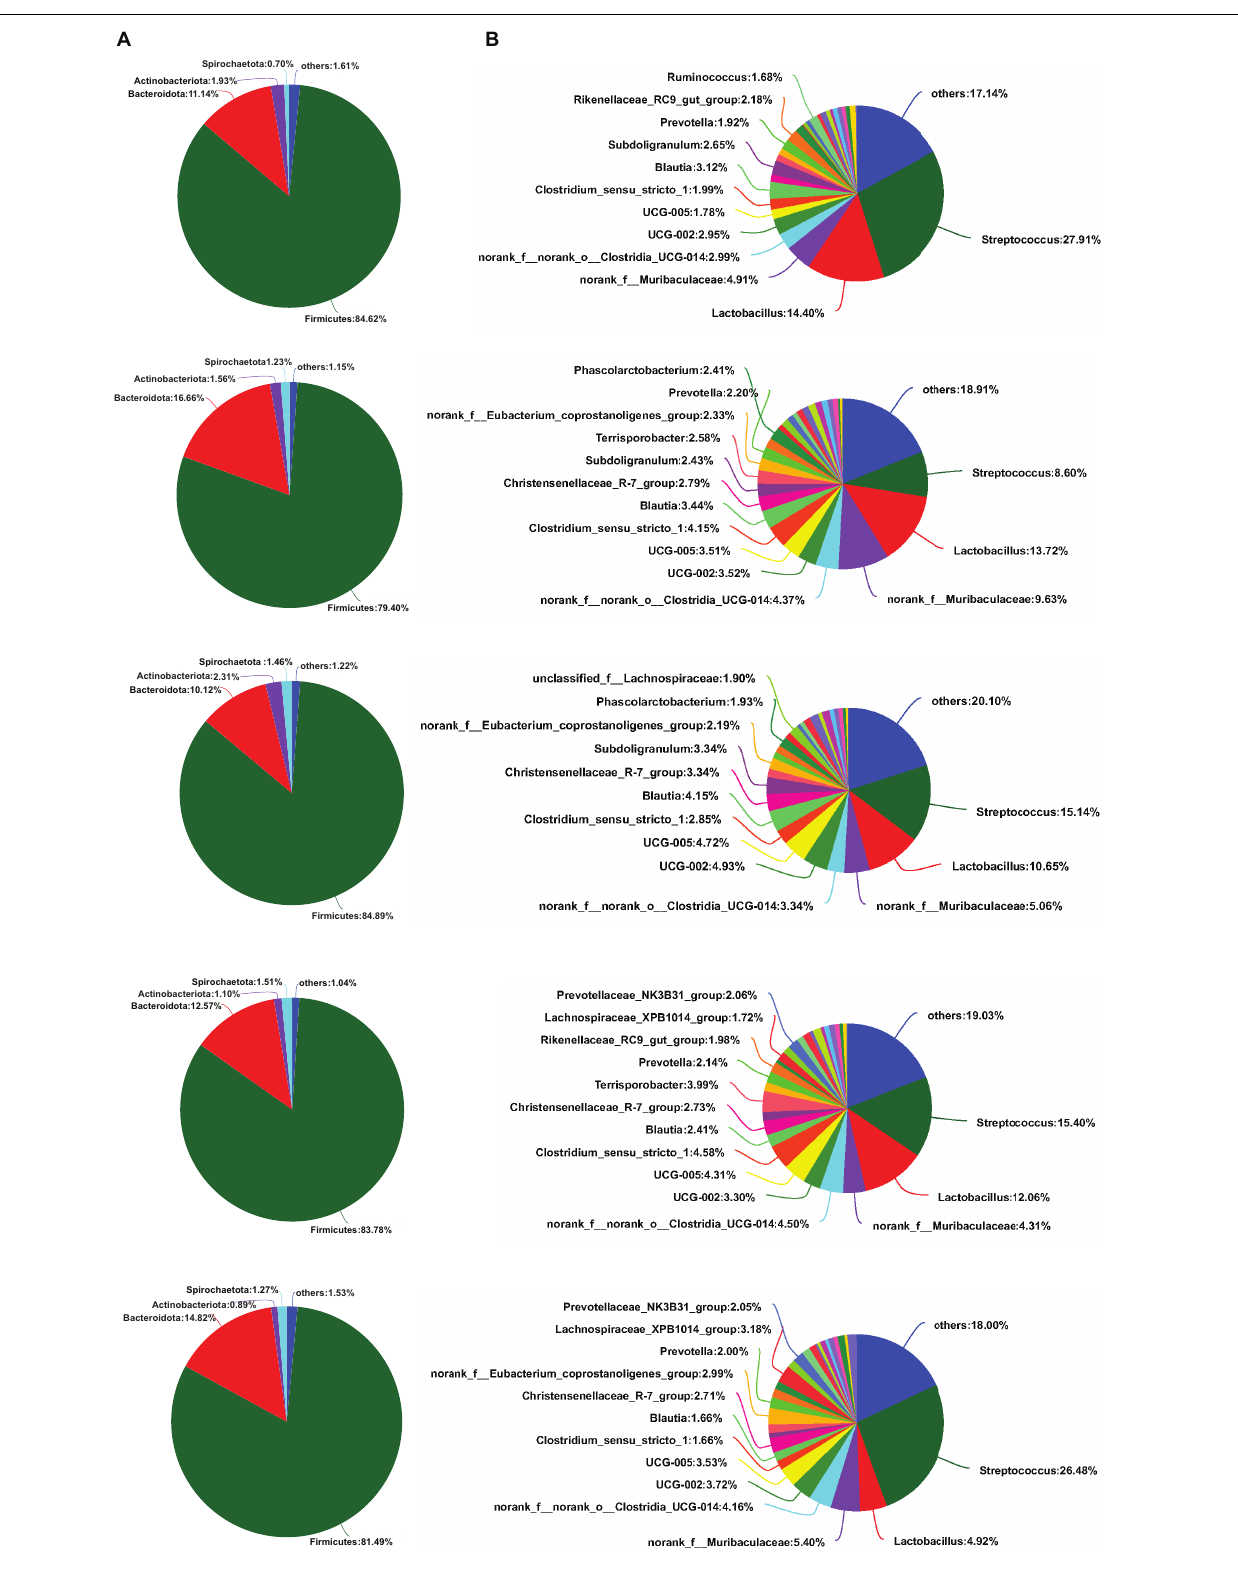
FIGURE 5 | Effects of different diets on the colonic bacterial community structure in weaned piglets. (A) Distribution of colonic bacteria at the phylum level in weaned piglets. (B) Distribution of colonic bacteria at the genus level in weaned piglets.